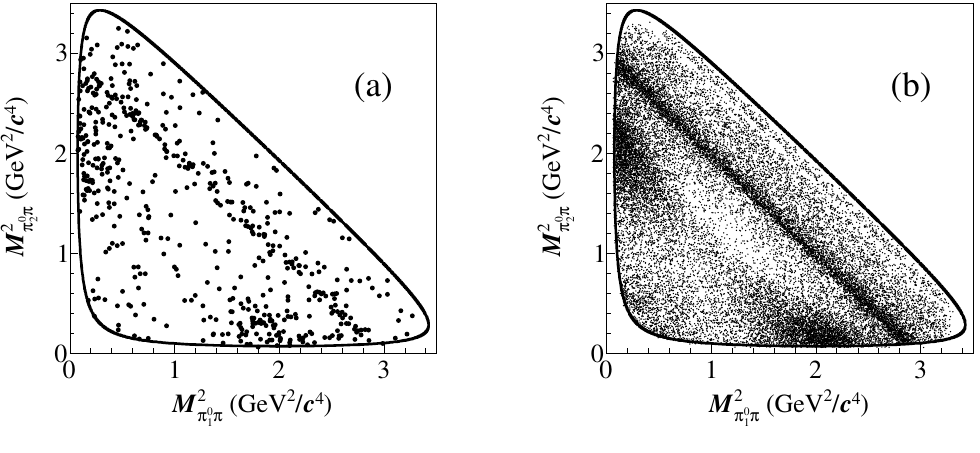
Figure 2 . The Dalitz plot of M 2 MC sample generated based on the results of the amplitude analysis at symmetrized for the indistinguishable π 0